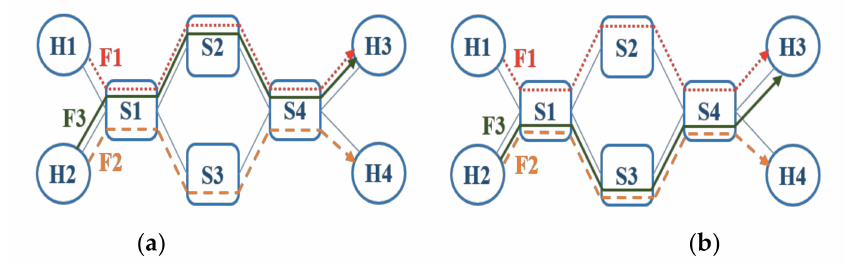
Figure 2. The example of two di ff erent routing schemes shown in ( a ) and ( b ) respectively.